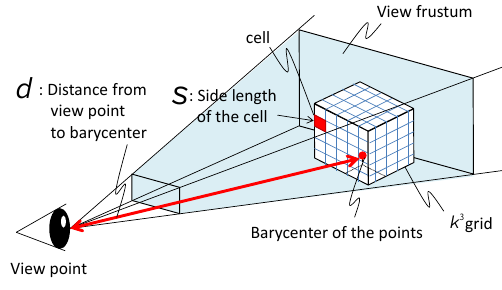
Figure 4. Each symbol